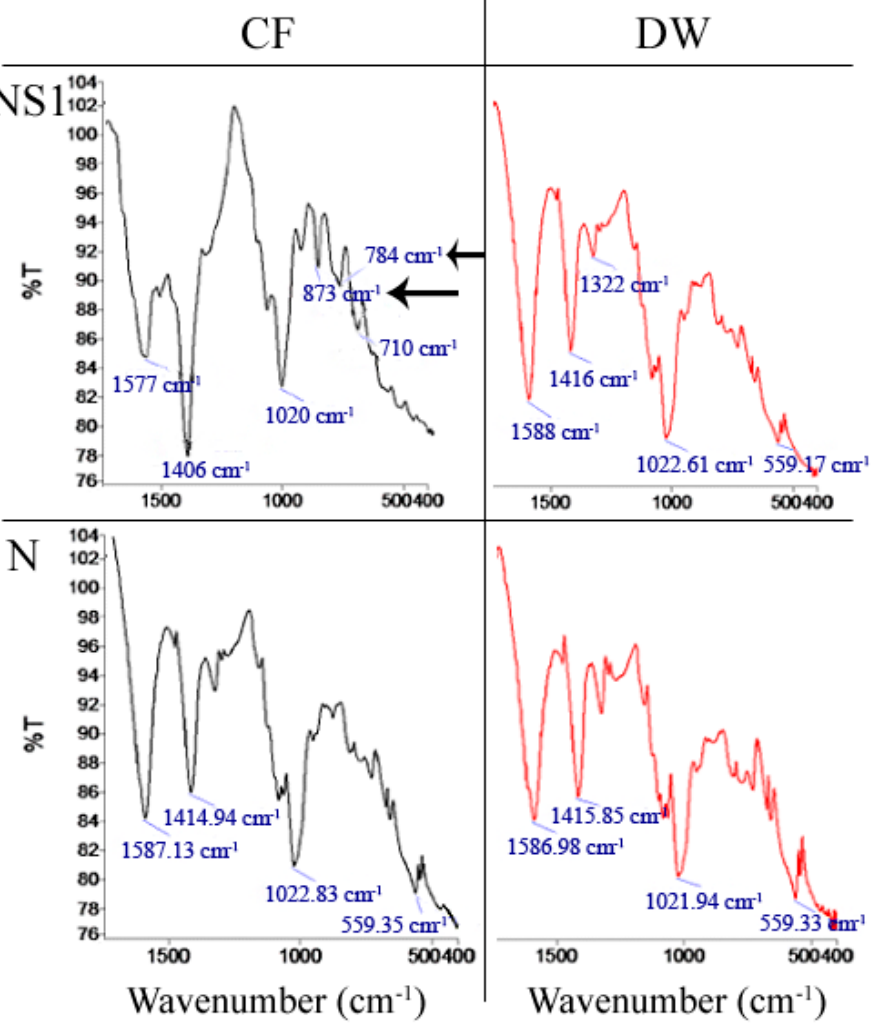
Figure 9. Fourier Transform Infrared (FTIR) spectra of NS1 and N capsules resuspended in CF or DW.